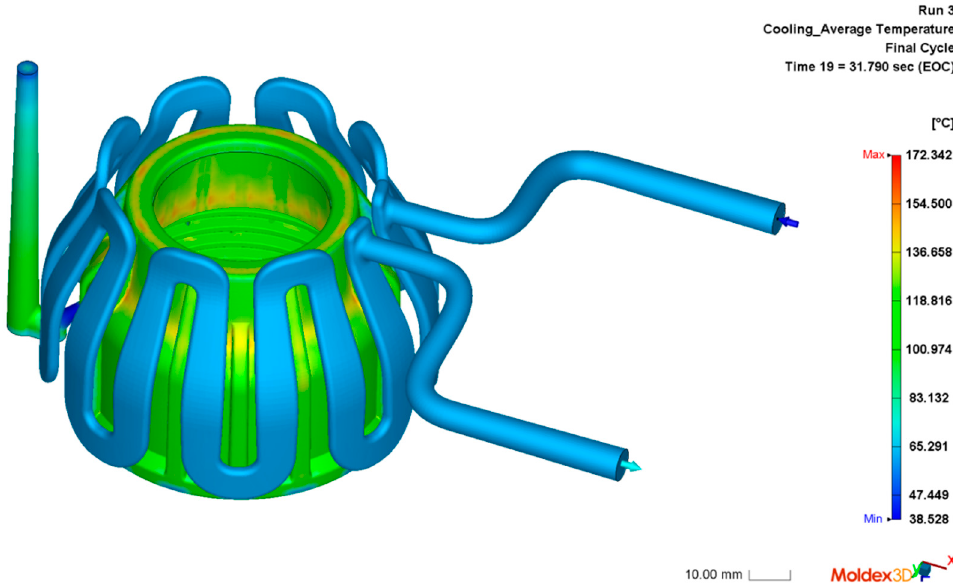
Figure 13. Temperature measurements with infrared thermal camera after ejection demonstrating the temperature reduction on the cap product when applying conformal cooling (top left) compared to conventional cooling (top right) and simulated temperatures of cap with conformal cooling by means of FEA immediately after ejection with an average temperature of the cap of 110 °C (bottom).